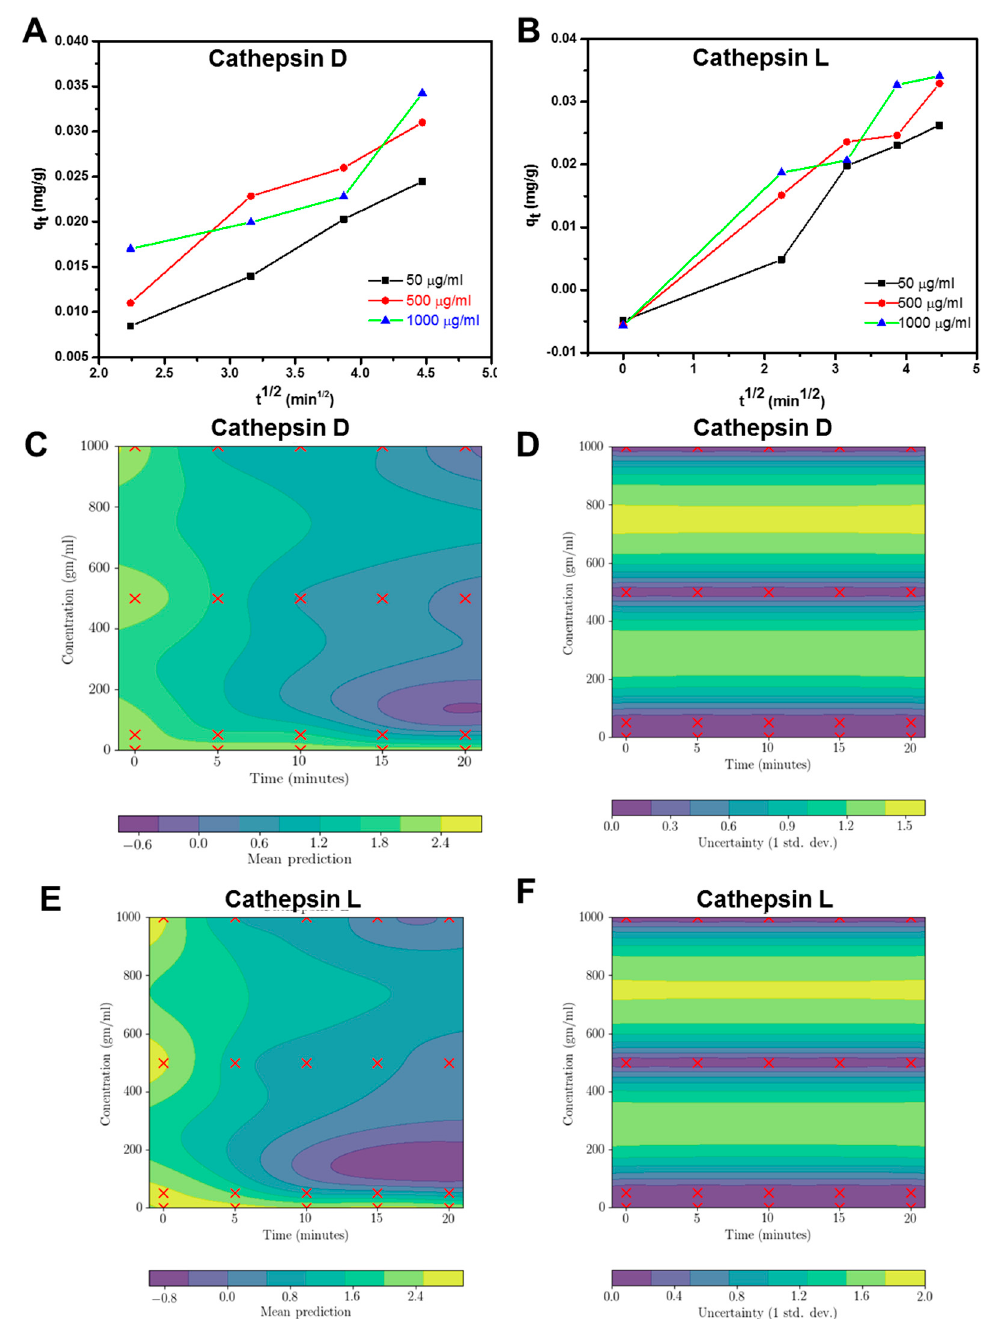
Figure 5. ( A , B ) Kinetic models fitting to the data for CathD and CathL using piecewise linear regression analysis of experiments in which ( A ) CathD and ( B ) CathL were adsorbed onto GO. ( C – F ) Gaussian process regression models to find the prediction and uncertainty in adsorption of CathD ( C , D ) and CathL ( E , F ) relating independent variables (time and concentration) to the dependent variable (absorption). In C and E , the mean predictions are depicted, and the uncertainty in predictions is shown in D and F .